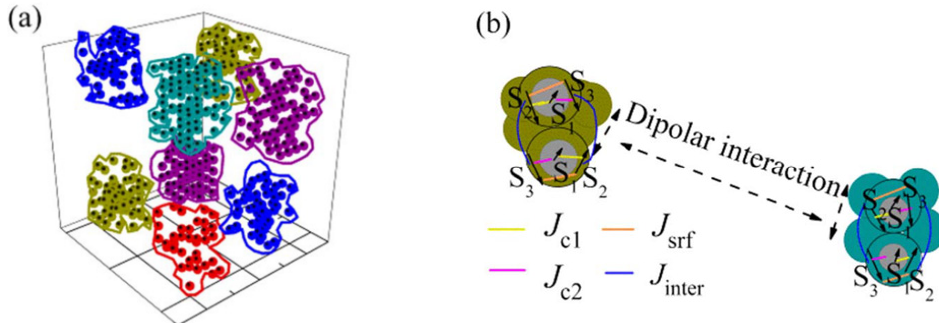
Figure 11. Modeling of the albumin coated clusters of ultra-small MnFe 2 O 4 nanoparticles with a core/surface morphology ( a ); enlarged schematic representation of two selected dipolarly interacting pairs of nanoparticles, core (S 1 )/surface (S 2 ,S 3 ), that belong to two neighboring clusters ( b ). In each pair, the exchange intraparticle (J c1 , J c2 , J srf ) and the exchange interparticle interactions (J inter ) between macrospins are depicted. The figure is reproduced with permission from Vasilakaki et al. [39].